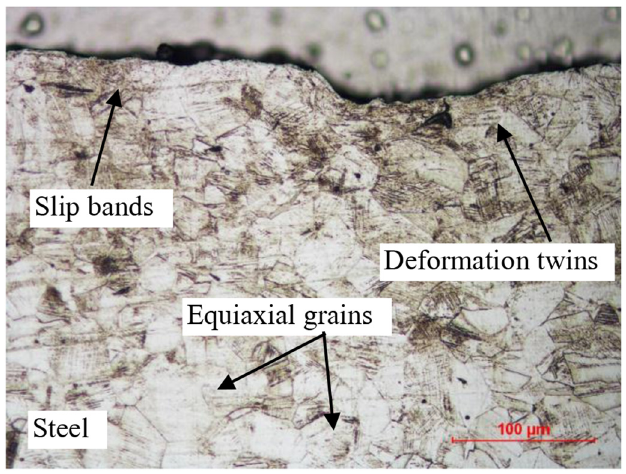
Fig. 3. Microstructure of stainless steel near the bond in specimen without the heat treatment.